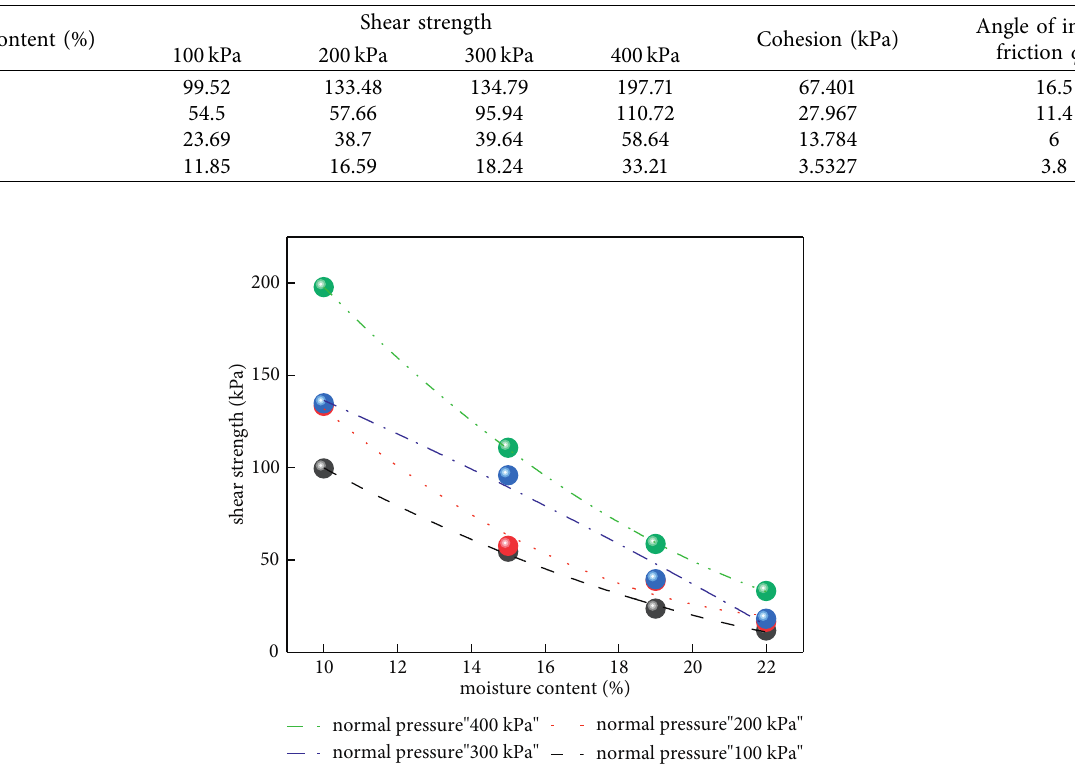
Table 6: Values of shear strength and strength index parameters at different moisture contents.